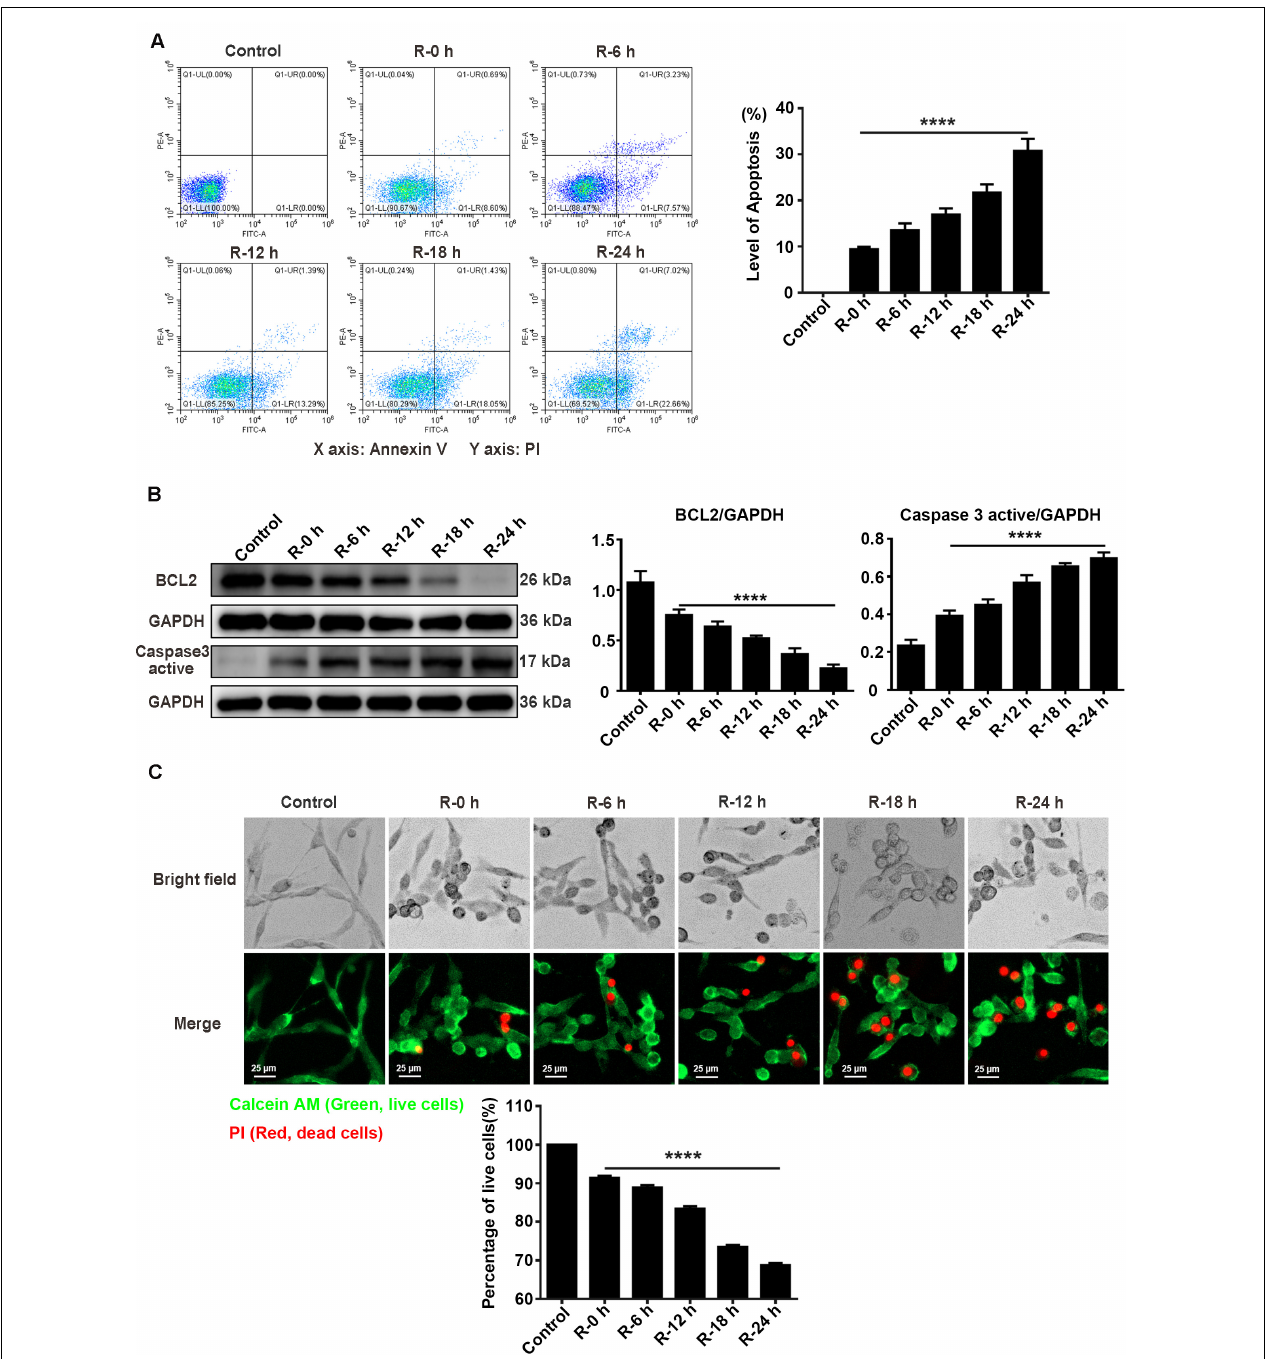
FIGURE 3 | The apoptosis level and percentage of live cells at different time points of reperfusion under OGD/R injury condition in PC12 cells. (A) Apoptosis levels in PC12 cells at 0, 6, 12, 18, and 24 h of reperfusion after 6 h of OGD stimulation. Annexin V-FITC/PI double staining assay by the flow cytometry was used to detect the dynamic change of apoptosis levels. A total of 10,000 cells were counted for each flow cytometry analysis. **** , compared with R-0 h group; P < 0.0001. X-axis: Annexin V; Y-axis: PI. (B) BCL2 and Caspase 3 active protein expression at different time points of reperfusion. The western blotting assay was used to detect the protein expression BCL2 and Caspase 3 active at different time points (0, 6, 12, 18, and 24 h) of reperfusion after 6 h of OGD stimulation. **** , compared with R-0 h group; P < 0.0001. (C) The percentage of live cells at different time points of reperfusion under OGD/R injury condition. Live/Dead cell staining was used to measure the percentage of live cells at different time points of reperfusion. Cells were stained with Calcein AM (green; live cells) and PI (red; dead cells). **** , compared with R-0 h group; P < 0.0001. Scale bars: 25 µ m.